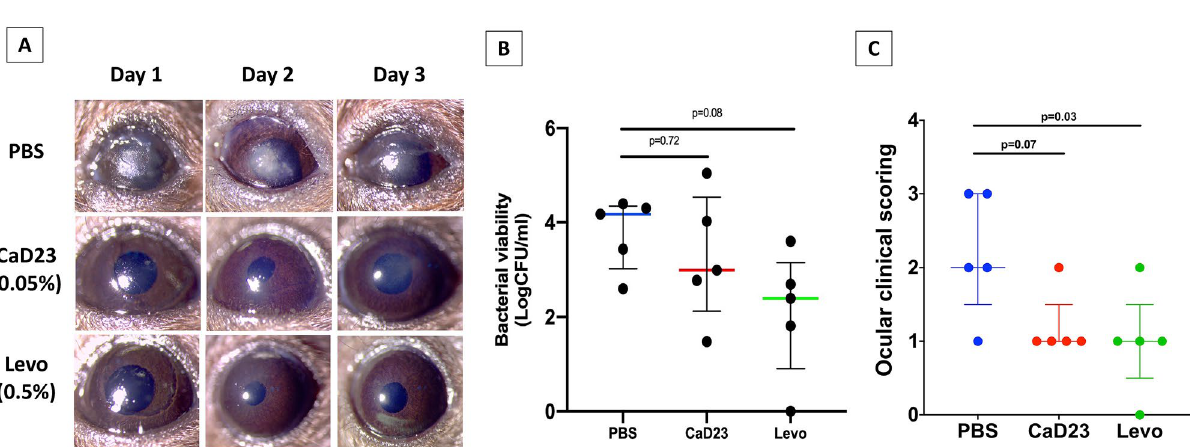
Figure 7. In vivo efficacy of CaD23 0.05% (500 μg/ml), levofloxacin 0.5% (positive control) and phosphate buffer solution (PBS; negative control) in a murine S. aureus ATCC SA29213 bacterial keratitis model (n = 5 mice/treatment group). ( A ) Representative slit-lamp images showing the corneal appearance over 3 days post-infection in each treatment group. Note the significant infiltrative changes of cornea in the PBS group as compared to the CaD23 0.05% and levofloxacin 0.5% groups. ( B ) Scatter plot showing the bacterial viability of S. aureus (in log 10 CFU/ml) after 3 days of treatment. In view of the wide range of results, data is presented as median ± interquartile range. ( C ) Scatter plot showing the ocular clinical scoring of the clinical appearance of the S. aureus -infected corneas treated by different treatment. The data is presented as median ± interquartile range. The scores are interpreted as follows: 0: Clear cornea or minimal opacity, partially covering the pupil; (b) + 1: Mild opacity, partially/fully covering the pupil; (c) + 2: Dense opacity, partially covering the pupil; (d) + 3: Dense opacity fully covering the pupil; and (e) + 4: Corneal perforation or